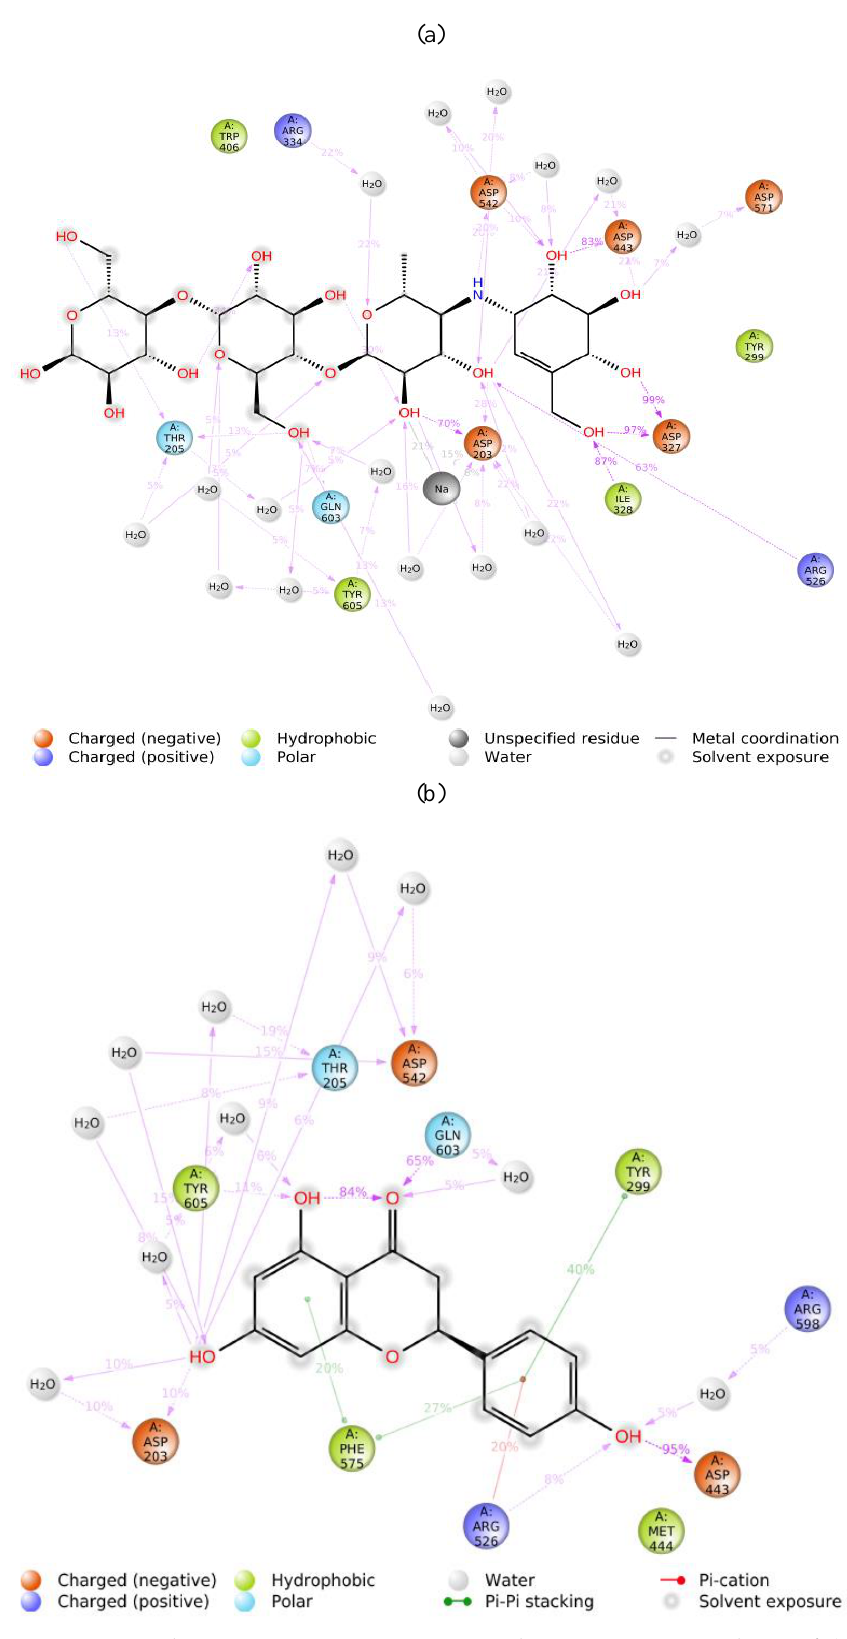
Figure 6. Ligand-receptor interaction percentages during 20 ns MD simulation of: ( a ) acarbose and ( b ) naringenin. Interactions that occurred for >5.0% of the simulation time are shown.